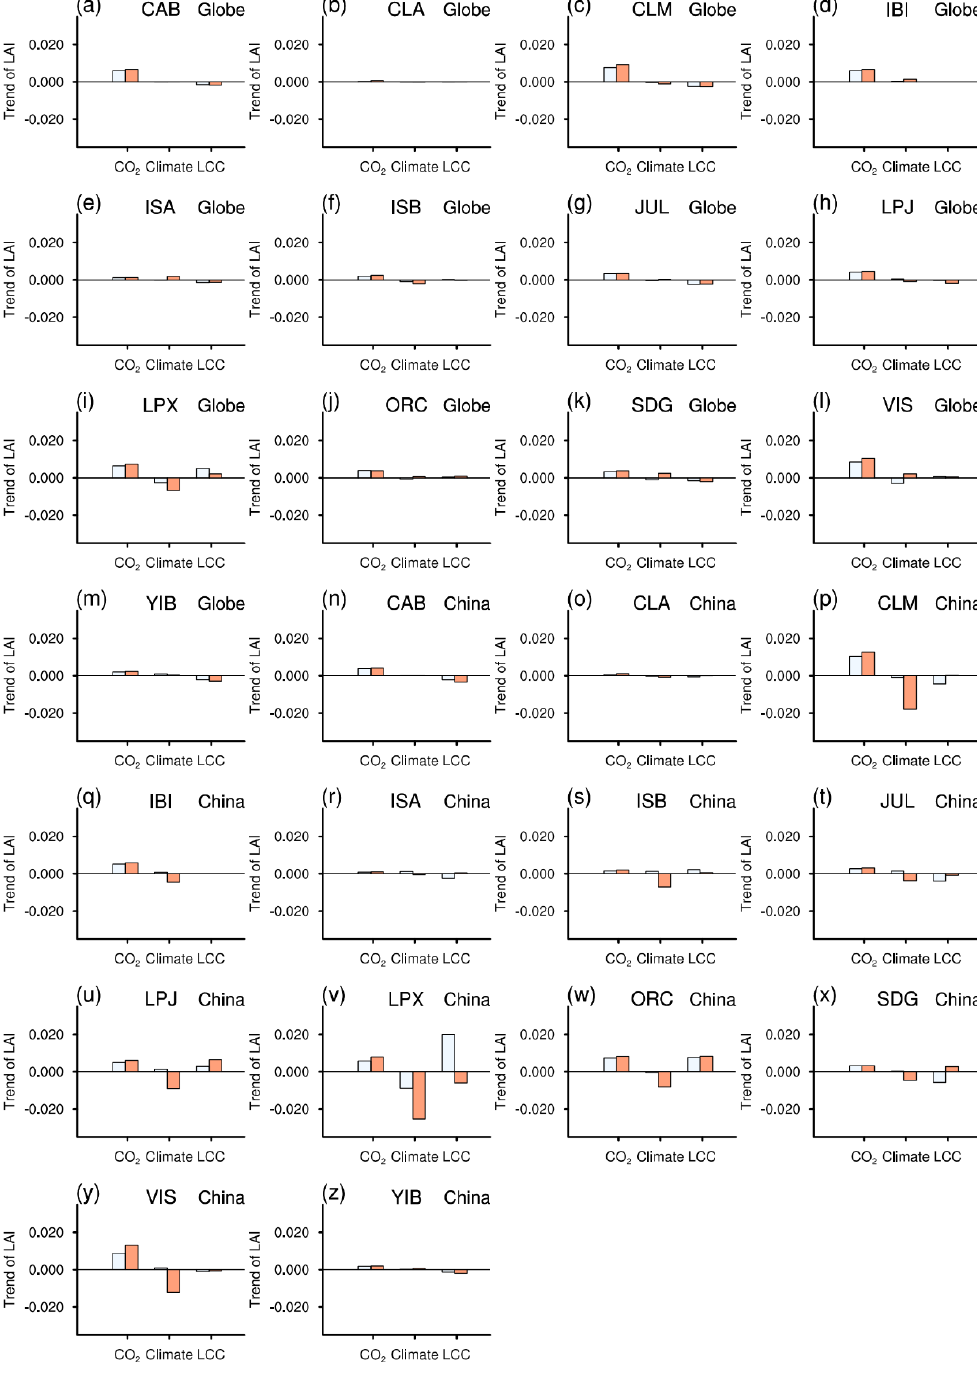
Figure 7. Trends in averaged LAI derived from each TRENDY model driven by rising CO 2 concentra- tions (CO 2 ), climate change (Climate), and land-use change (LUC) for the globe in ( a – m ) and China in ( n – z